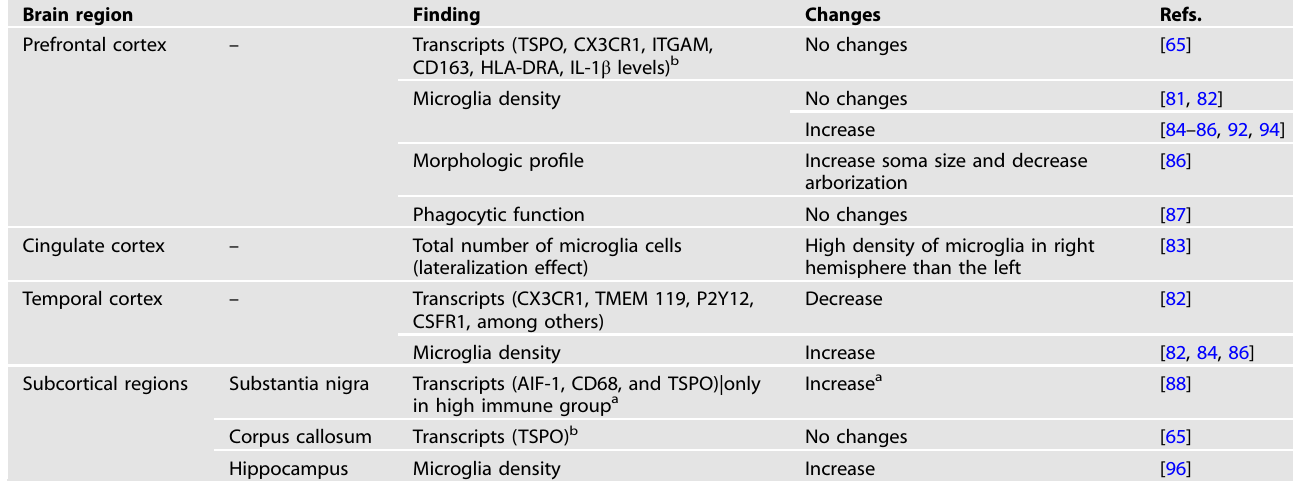
Table 2. Microglia sequelae in schizophrenia patients (post-mortem